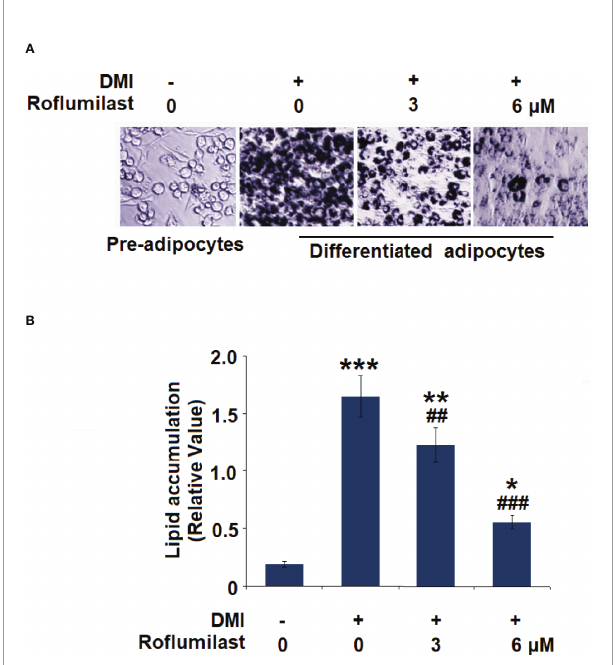
FIGURE 3 | Effect of Ro fl umilast on triglycerides content and lipolysis. Cells were incubated with a differentiation cocktail (DMI) medium with Ro fl umilast (3 and 6 m M). (A) Total level of triglycerides; (B) Lipolysis is shown as glycerol release (*, **, ***, P < 0.05, 0.01, 0.005 vs. vehicle group; ## , ### , P < 0.01, 0.005 vs. DMI group, n =